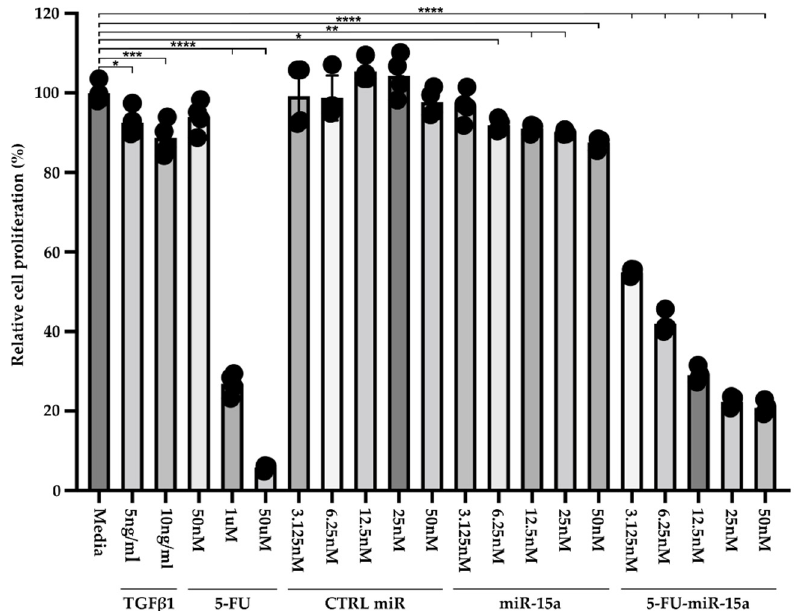
Figure 4. Dose-response treatment of murine pancreatic stellate cells. Pancreatic stellate cells were treated with TGF β 1, 5-FU, CTRL miR, miR-15a, and 5-FU-miR-15a for six days, and cell viability was assessed using Cell-Titer Glo and compared to the control (medium). Data are represented as the mean ± SD; N = 4. * p < 0.05, ** p < 0.01, *** p < 0.001, and **** p < 0.0001 by One-Way ANOVA.